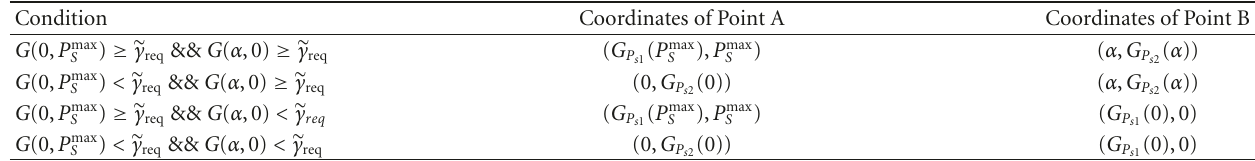
Table 1: Four subcases for the solution